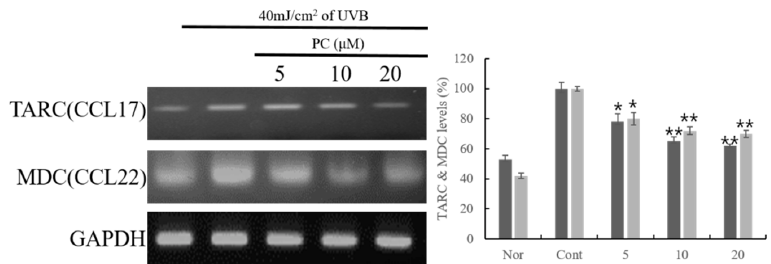
Figure 1. Effect of PC ( 1 )-treated HaCaT cells on MDC and TARC expression. HaCaT cells were pre-treated with different concentrations of PC ( 1 ) (5, 10, 20 μ M) for 1 h. The cells were further stimulated with 40 mJ/cm 2 UVB. After 6 h, the cells were harvested, and relative mRNA levels were determined. Histograms show the densitometric data for TARC and MDC mRNA normalized to the level of GAPDH. Each value represents the mean ± SD of three individual experiments. Nor: Non-treated cell group (0 h), Cont: 40 mJ/cm 2 UVB-treated cell group. Data are expressed as the means ± S.D., n = 3. * p < 0.001 and ** p < 0.0001 compared to the control group.